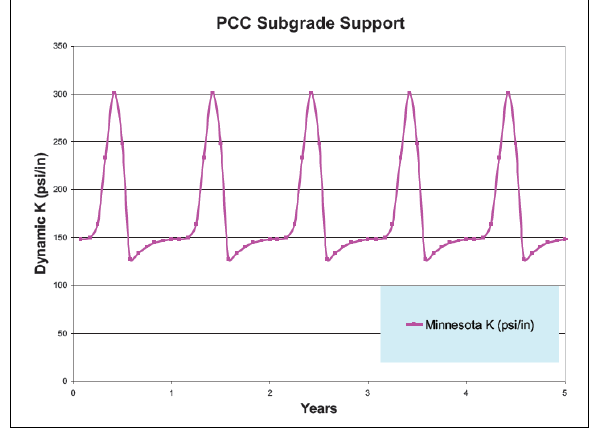
Figure 3: Soil property (k-Value) adjustment